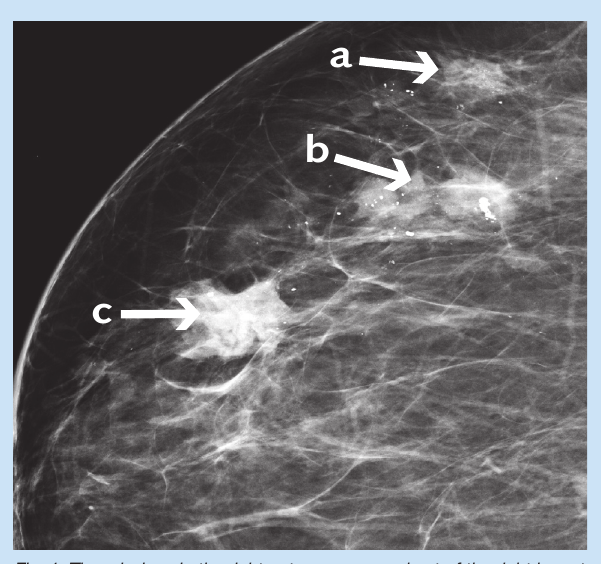
Fig. 1. Three lesions in the right outer, upper quadrant of the right breast (labelled a, b,